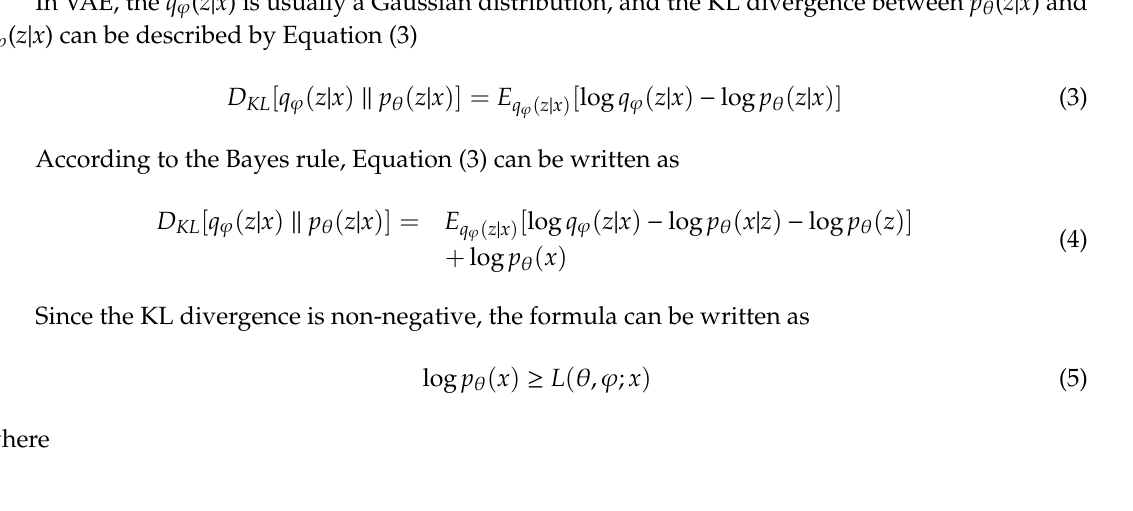
Figure 2. The probability graph model of variational autoencoder (VAE).